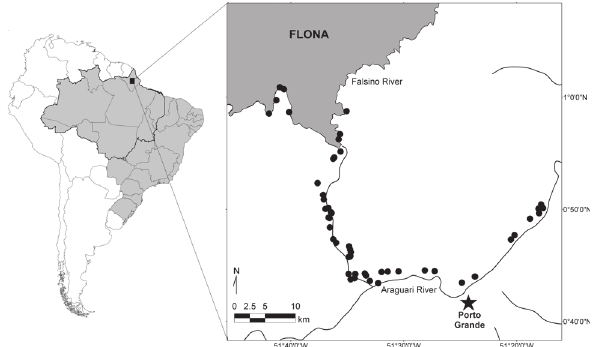
Figure 1. Location of the study area in Amapá State, eastern Bra- zilian Amazon. The location of the 51 interviews (solid circles) conducted between March, 2011 and May, 2012, and the near- est urban centre (Porto Grande – solid star). The shaded polygon shows the limits of the National Forest of Amapá (FLONA) and lines the centre of the Falsino and Araguari river channels.